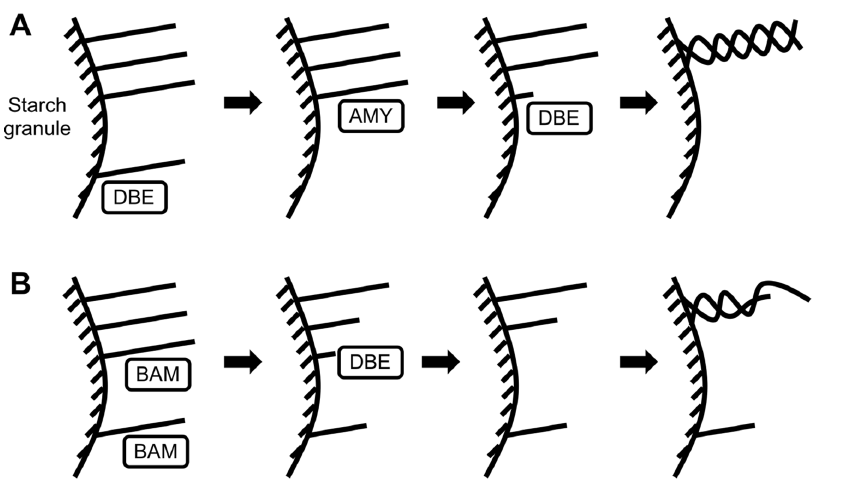
Figure 4. Model for the roles of AMY and BAM in Arabidopsis transient starch biosynthesis. ( A ) In the wild-type plant, loosely spaced branches are trimmed by DBE effectively; AMY hydrolyzes branches to short glucan stubs for further debranching. This produces a crystallization- competent structure. ( B ) In the ISA-type DBE mutant, the highly branched polysaccharide is more susceptible to b -hydrolysis which produces varying lengths of glucan stubs. Debranching and trimming by AMY and residual DBE activity are ineffective and thus delay crystallization.